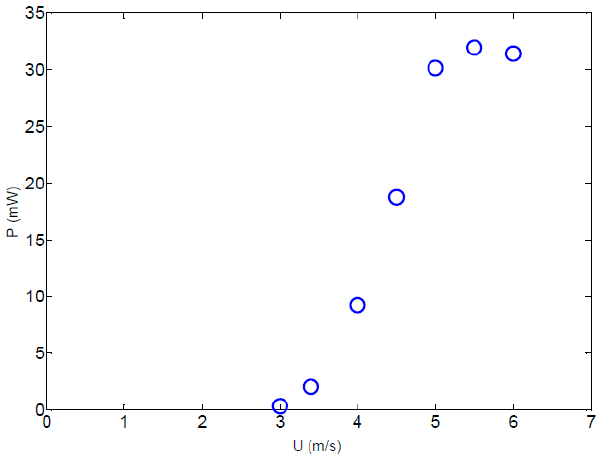
Figure 6. Power dissipated in the optimized load as function of wind velocity of a C = 20 mm, S = 70 mm fluttering wing.